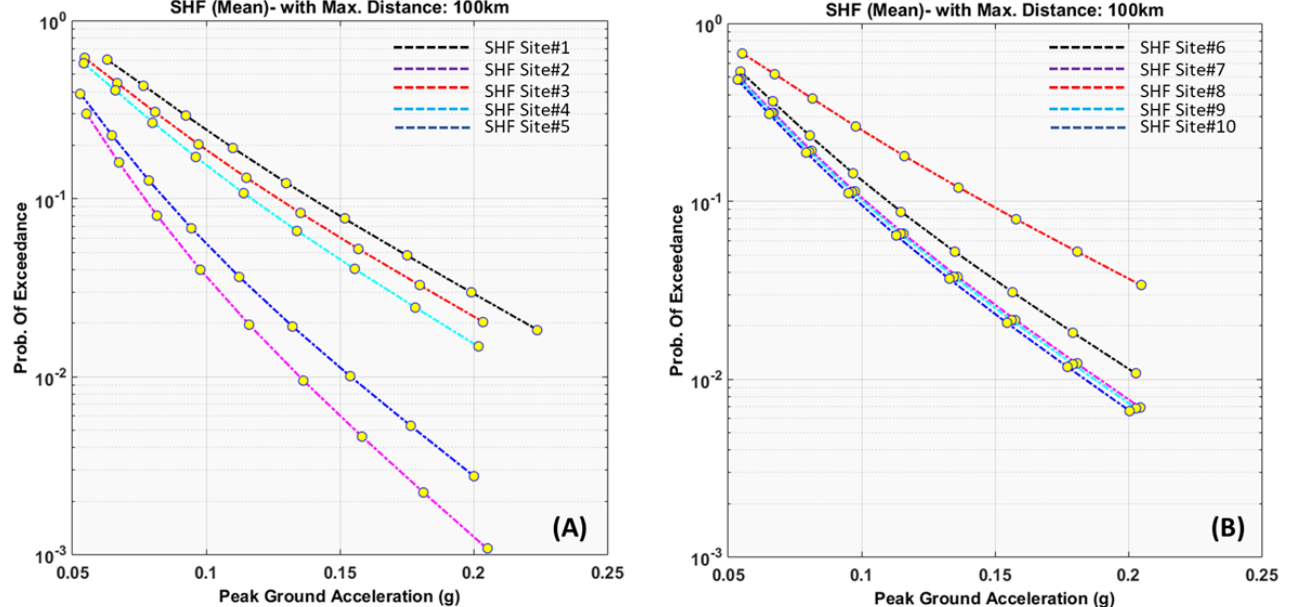
Figure 6. The graphs show the SHF curve of each observation point ( A , B ). The SHF curve of total probability of exceedance versus the mean of the peak ground acceleration of each observation point (sites #1 to #10) was constructed using the maximum radius distance of about 100 km with a magnitude range of 6.0–8.0. The source depth was set at half of the seismogenic thickness, which was about 20 km, and the starting locking depth of 5 km was used; thus, 15 km of the source depth was used. The period of the SHF evaluation was set at about 50 years.